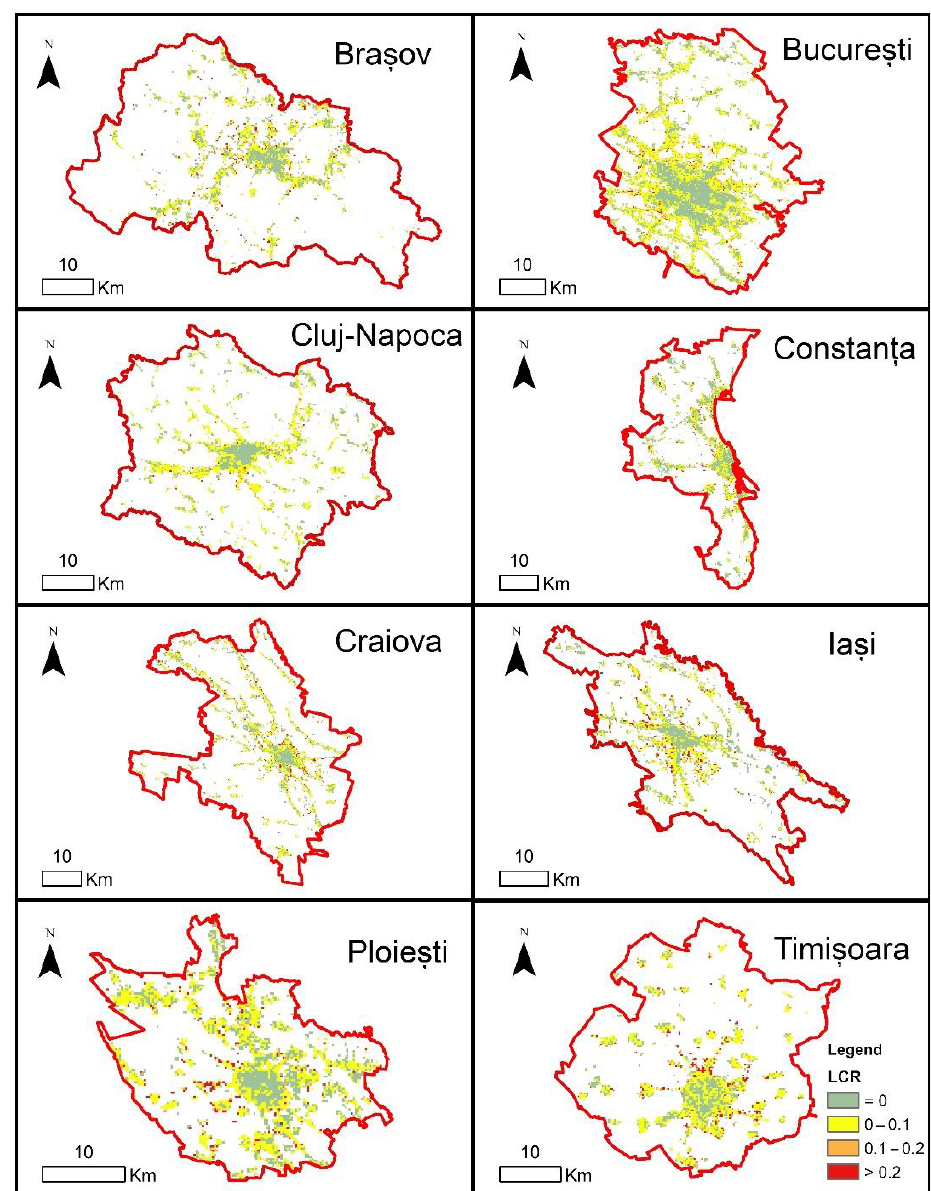
Figure 3. Distribution of the LCR values at grid level for 2000 – 2014.